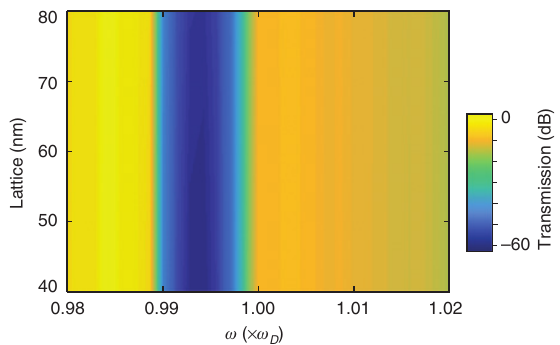
Figure 3: The transmission spectra for a lossless 30 × 30 array of = 1500 THz, calculated using meta-molecules with R / a = 3.15 and f p the coupled dipole method. It can be observed that the band gap (range of frequencies over which transmission is minimum) remains independent of the lattice constant.